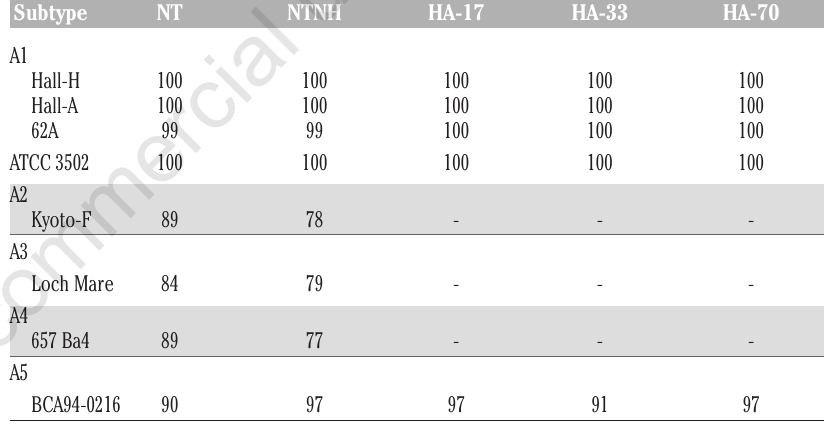
Table 2. Comparison of percentage amino acid identity of neurotoxin and neurotoxin associated proteins genes in serotype A of C. botulinum .